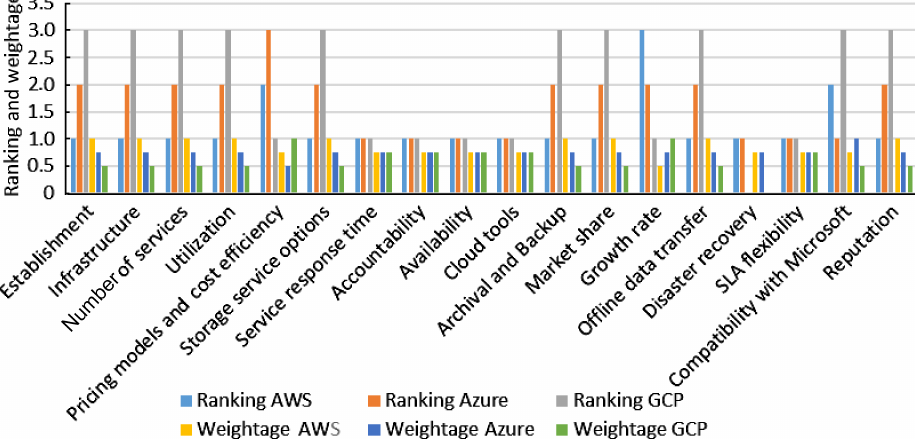
Fig. 2 Parameter-ranking and